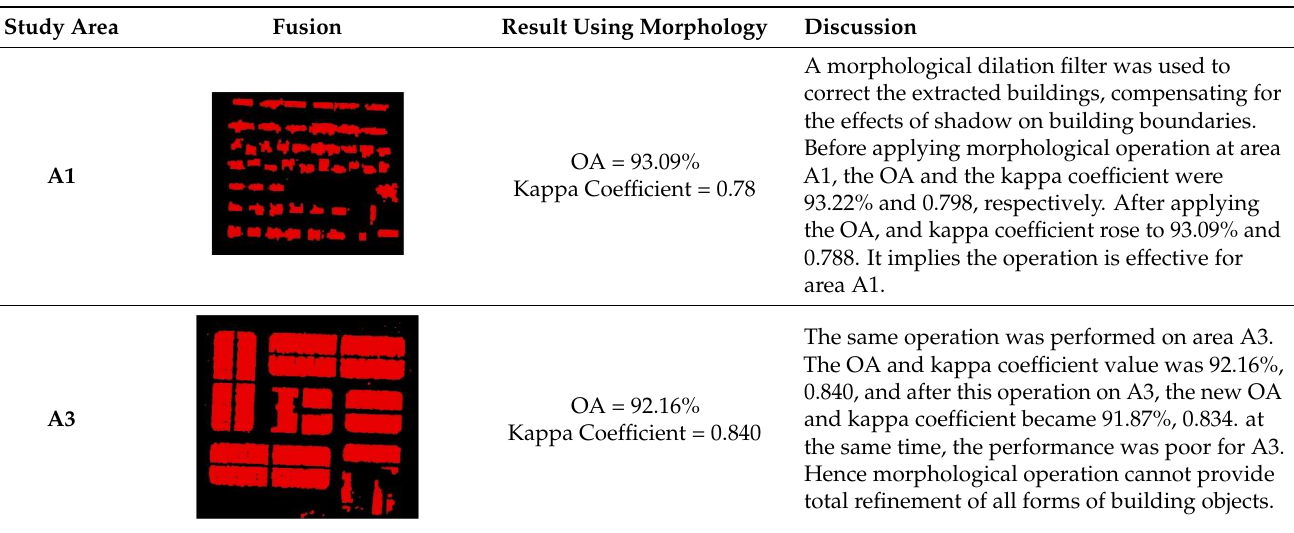
Table 5. The result of applying morphology to the proposed CNN technique. Study